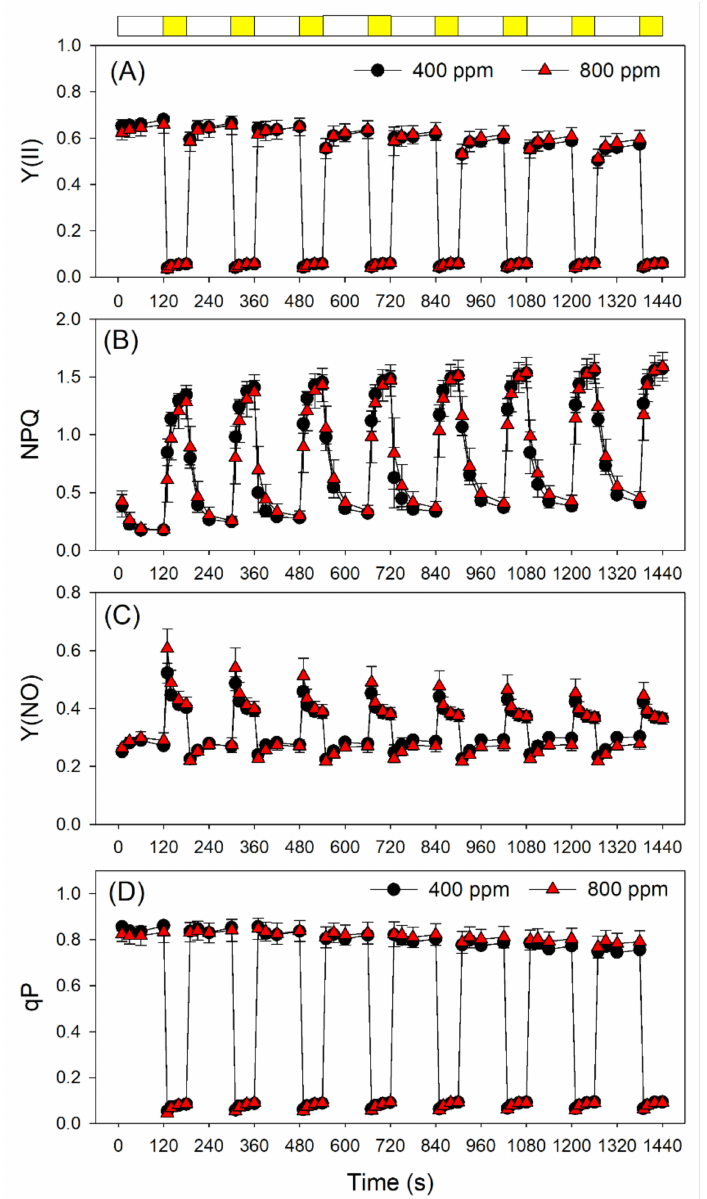
Figure 4. Changes in PSII parameters during fluctuating light alternating between 59 and 1809 µ mol photons m − 2 s − 1 in Arabidopsis leaves measured in 400 and 800 ppm CO 2 . ( A ) Y(II), the effective quantum yield of PSII photochemistry; ( B ) NPQ, non-photochemical quenching in PSII; ( C ) Y(NO), the quantum yield of non-regulatory energy dissipation in PSII; ( D ) the redox state of the plasto- quinone pool of PSII (qP). Data are shown as means ± SD ( n = 5). White bars indicate low light (59 µ mol photons m − 2 s − 1 ); yellow bars indicate high light (1809 µ mol photons m − 2 s − 1